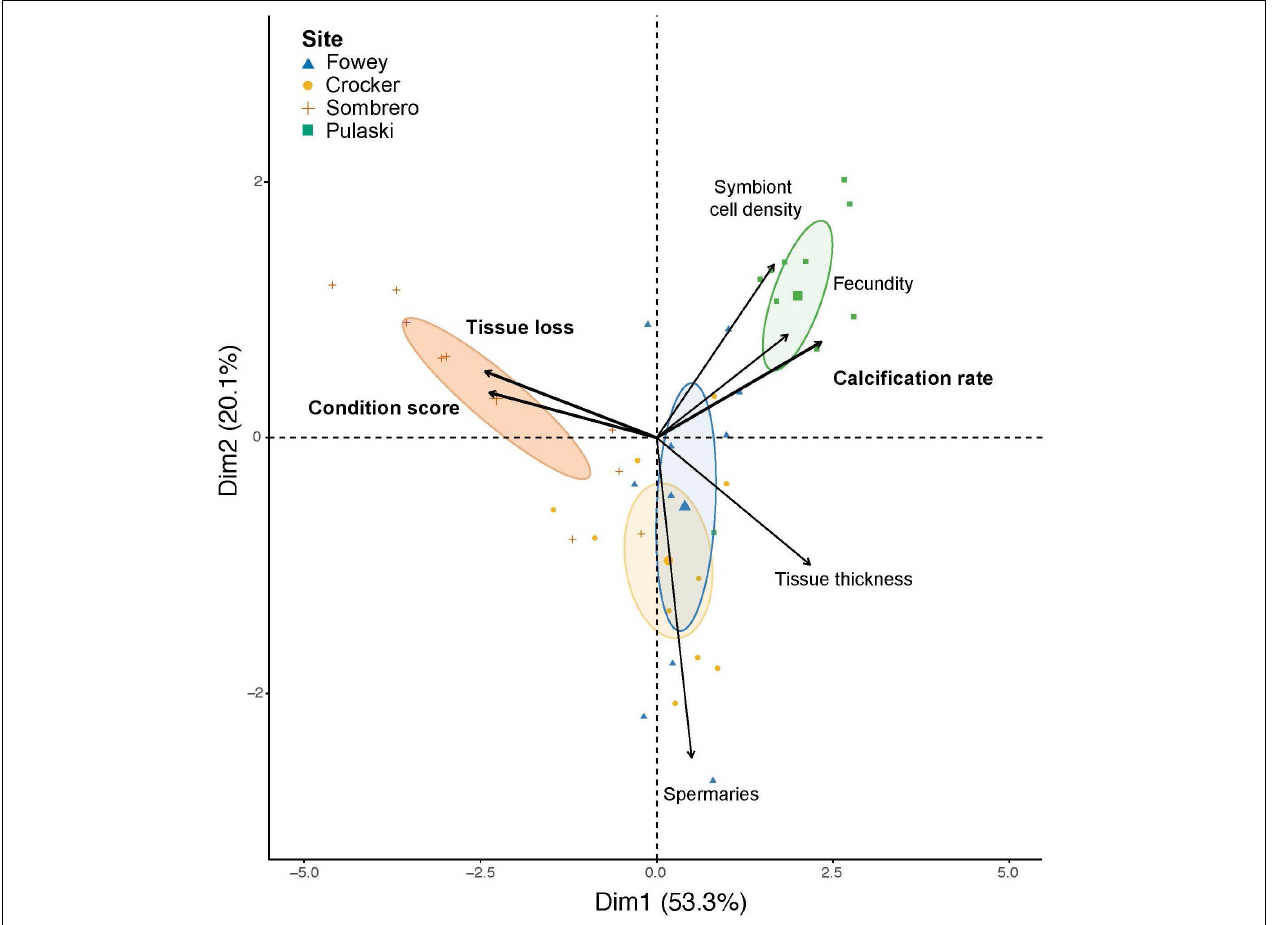
FIGURE 4 | Principal components analysis (PCA) of dimensions 1 and 2 explaining 83.4% of the variation when incorporating traits in corals destructively sampled at the end of the study: fecundity (oocytes and planula larvae per polyp), spermaries per polyp, Symbiodiniaceae cell densities, and tissue thickness with the three non-destructive traits measured and bolded (calcification rates, tissue loss, and condition score). Corals are from 4 sites on the Florida Key Reef Tract; 95% confidence ellipses are placed around the mean for each